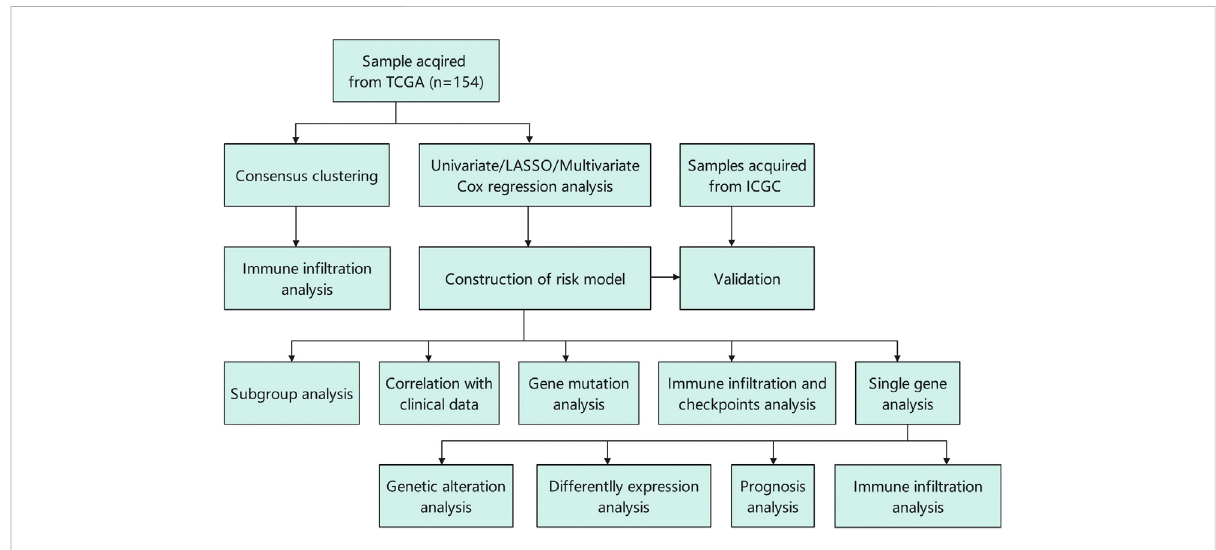
FIGURE 11 Flowchart of this